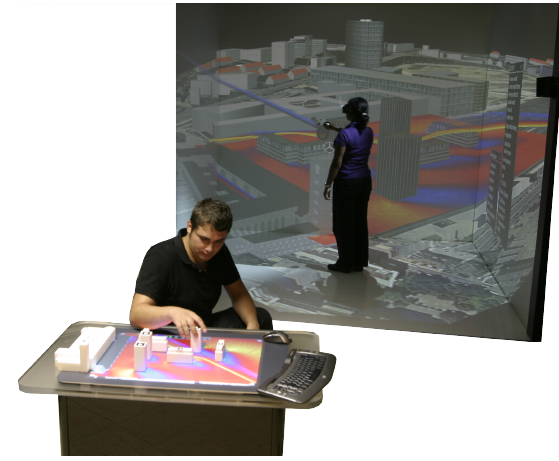
Fig. 1. CAVE and MultiTouch Table at the